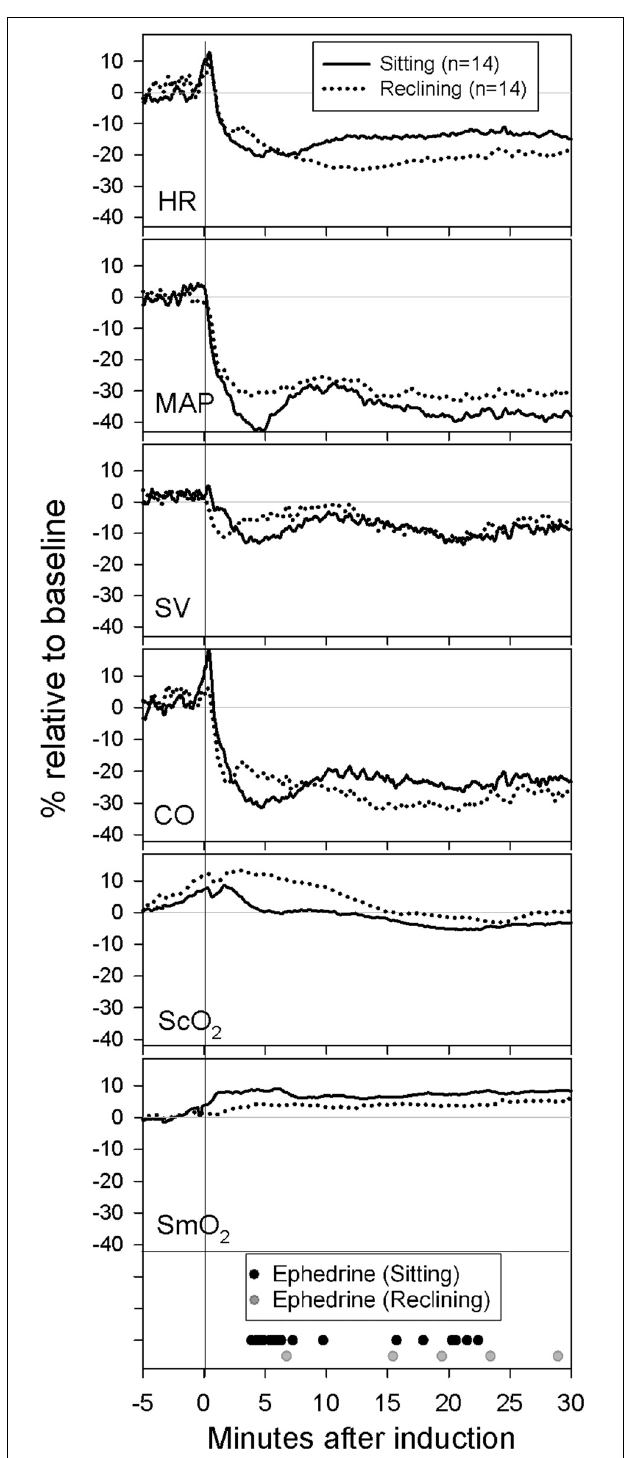
FIGURE 1 | Mean-values for all patients from 5min prior to induction until30minafterinduction. Baselinewasrecordedinthesittingbeach-chair position approximately 5min prior to induction. During the 5min prior to induction the patient was placed in the induction position (either sitting or reclining)withstartofpropofolandremifentanilinfusionsandpreoxygenation. Instances of individual ephedrine-administrations are shown.